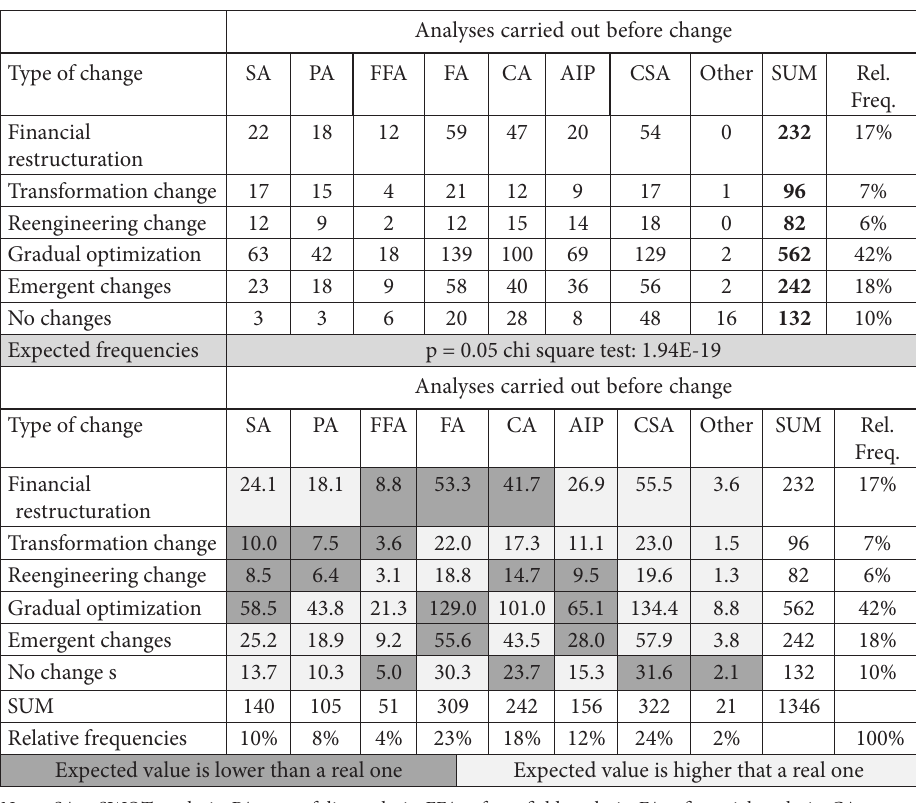
Table 3. Pivot table for type of change and analyses carried out before change (source: own processing) Analyses carried out before